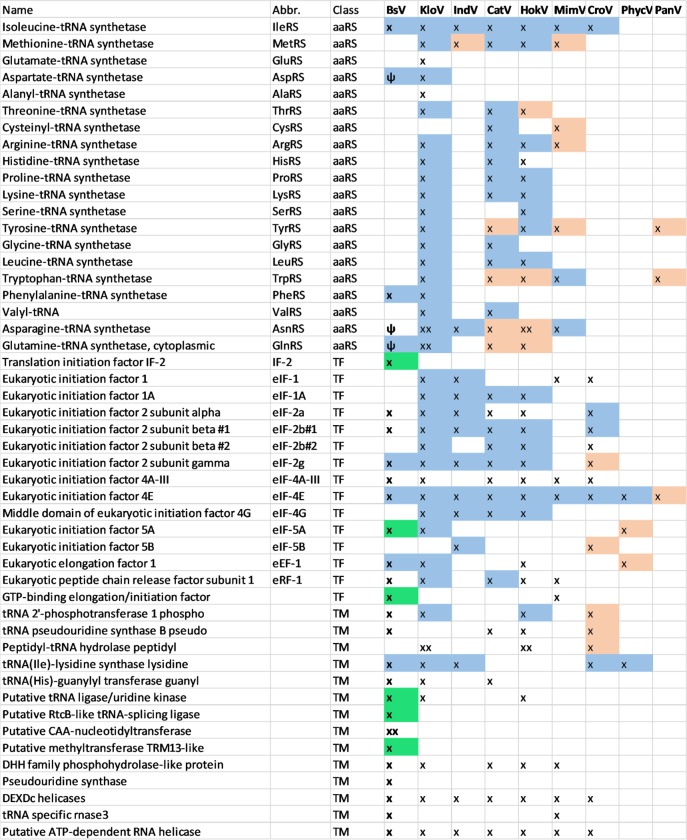
Comparison of translational machinery encoded by giant viruses based on phylogenetic analysis: BsV Translational machinery compared to other NCLDV: blue: monophyletic group, red: recently host acquired, green: recently acquired from bodonid host, ψ: pseudogene MimV: Mimiviruses, CatV: Catovirus, BsV: Bodo saltans virus, HokV: Hokovirus, KloV: Klosneuvirus (KlosnV), IndV: Indivirus, CroV: Cafeteria roenbergensis virus, PhycV: Phycodnaviridae, PanV: Pandoraviridae.10.7554/eLife.33014.013Figure 4—figure supplement 2—source data 1.Source data for Figure 4—figure supplement 2.